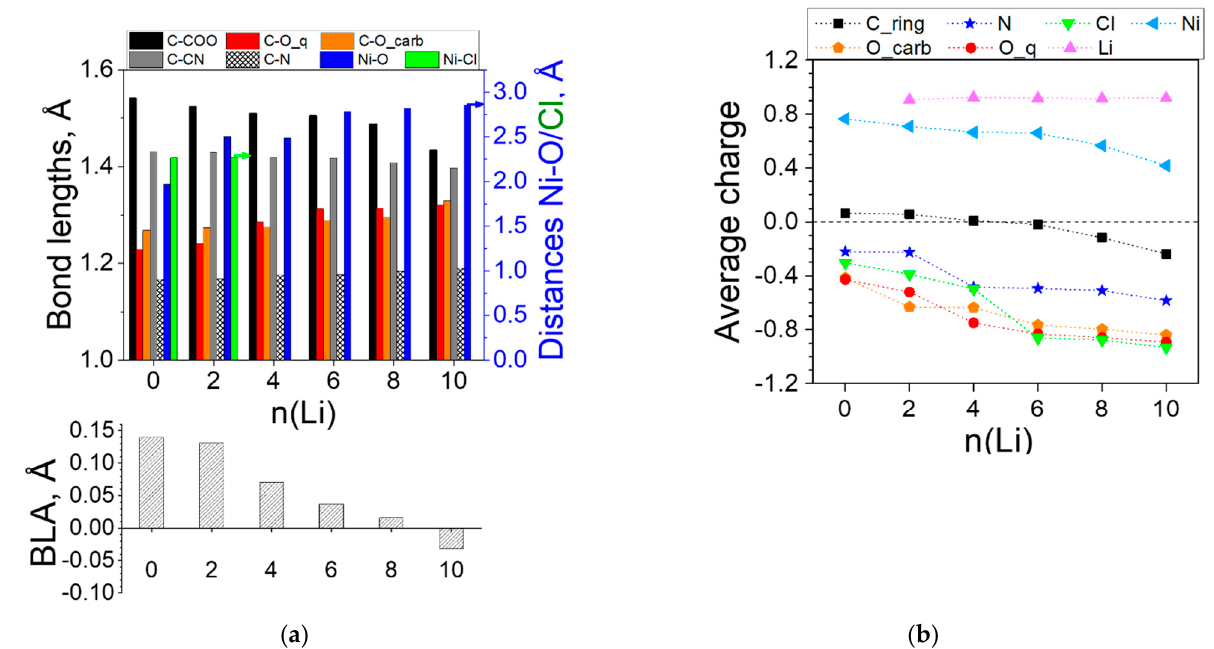
Figure 5. Ni(IV)(L1) 2 complex: ( a ) variation in the averaged bond lengths (Ni-O and Ni-Cl on the right axis) and BLA; ( b ) averaged charges upon introduction of n Li atoms. Numerical values can be found in Tables S4 and S5. Distances Ni-Cl are not shown after 2Li in ( a ) as they are too large and not informative (Table S4). Table 2. Multiplicity and N-to-N length (l mol ) of Ni(IV)(L1) 2 upon lithiation.